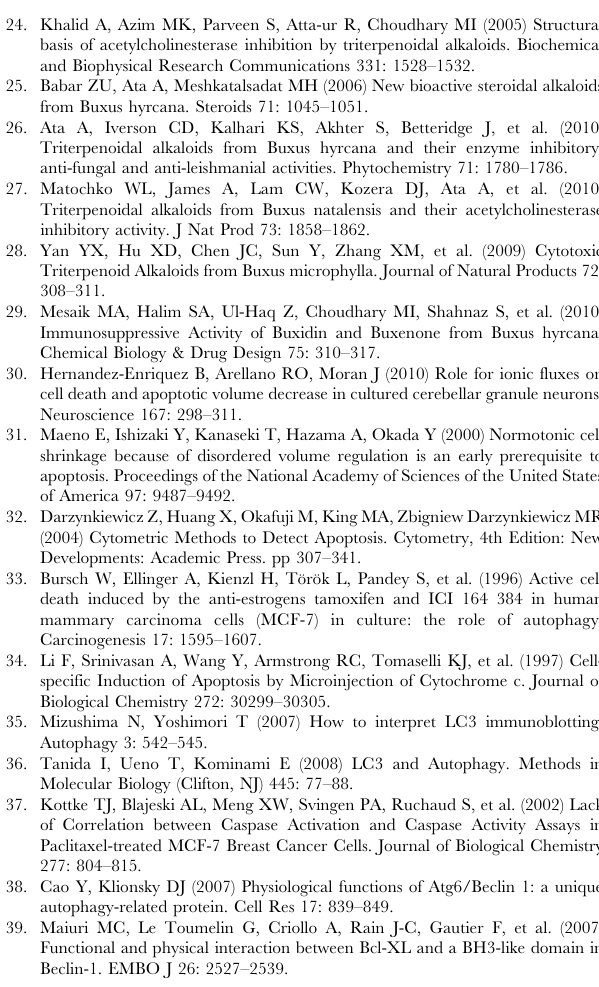
respectively, (IC 50 during 24 h and 48 h) demonstrating the occurrence of the processed form of LC3 and the decrease of p21 levels. Figure S6 Immunoblot analysis of total cell extracts isolated from MCF10A demonstrating the absence of the processed LC3II and caspase 3 in treated cells. Only a small band related to LC3II is present when cells were treated with MCF7-IC50. a -tubulin was used as a loading